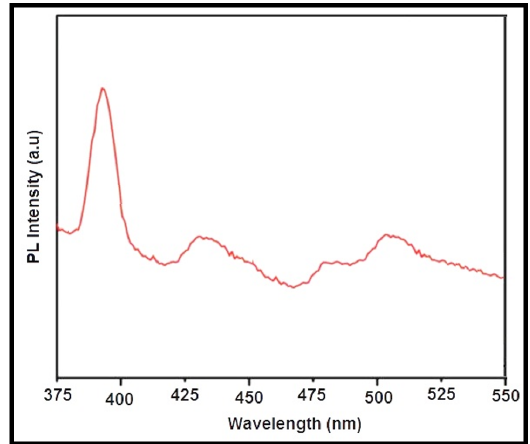
Fig.4. Photoluminescence spectrum of the TiO